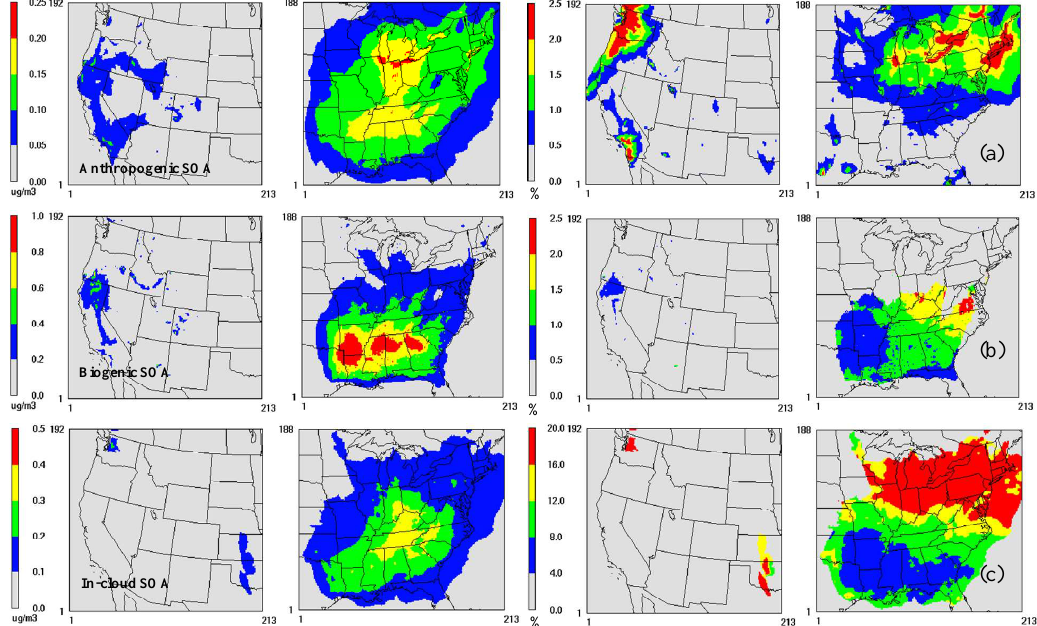
Figure 9: (a) monthly mean anthropogenic SOA with CB05-Base and percent increases in mean anthropogenic SOA between CB05-TU and CB05-Base (b) mean biogenic SOA with CB05- Base and percent increases between CB05-TU and CB05-Base (c) mean in-cloud SOA with CB05-Base and percent increases in mean in-cloud SOA between CB05-TU and CB05-Base. In each row, the first two plots represent mean values ( m g/m 3 ) and the last two plots represent percent changes (%).